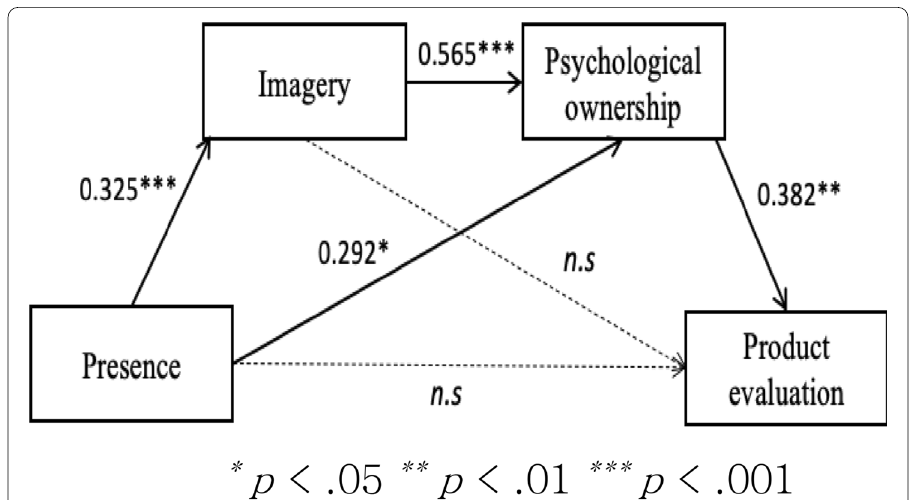
Fig. 8 Sequential mediation of imagery and psychological ownership in the effect of presence on product